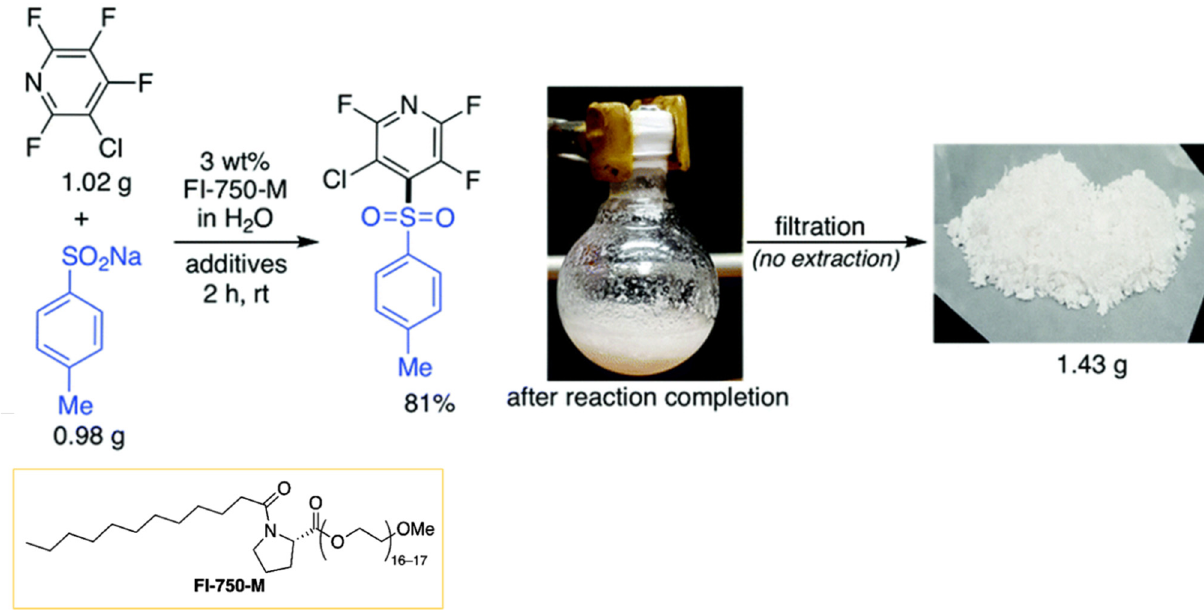
Figure 4. Gram-scale reaction of polyfluoroarene and sodium p -toluenesulfinate salt using FI-750-M micelles. The resulting product was recovered as a solid by filtration, so no organic solvent was required for extraction and purification. Adapted from [71] with permission.